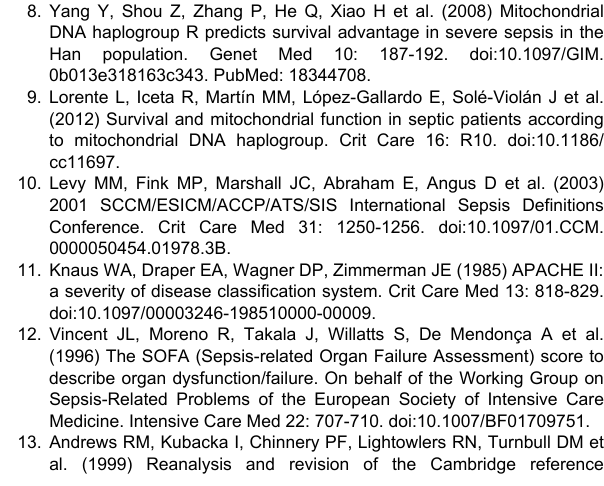
S1. Patients’demographic and clinical characteristics according to mtDNA haplogroups of the 96 patients of the first